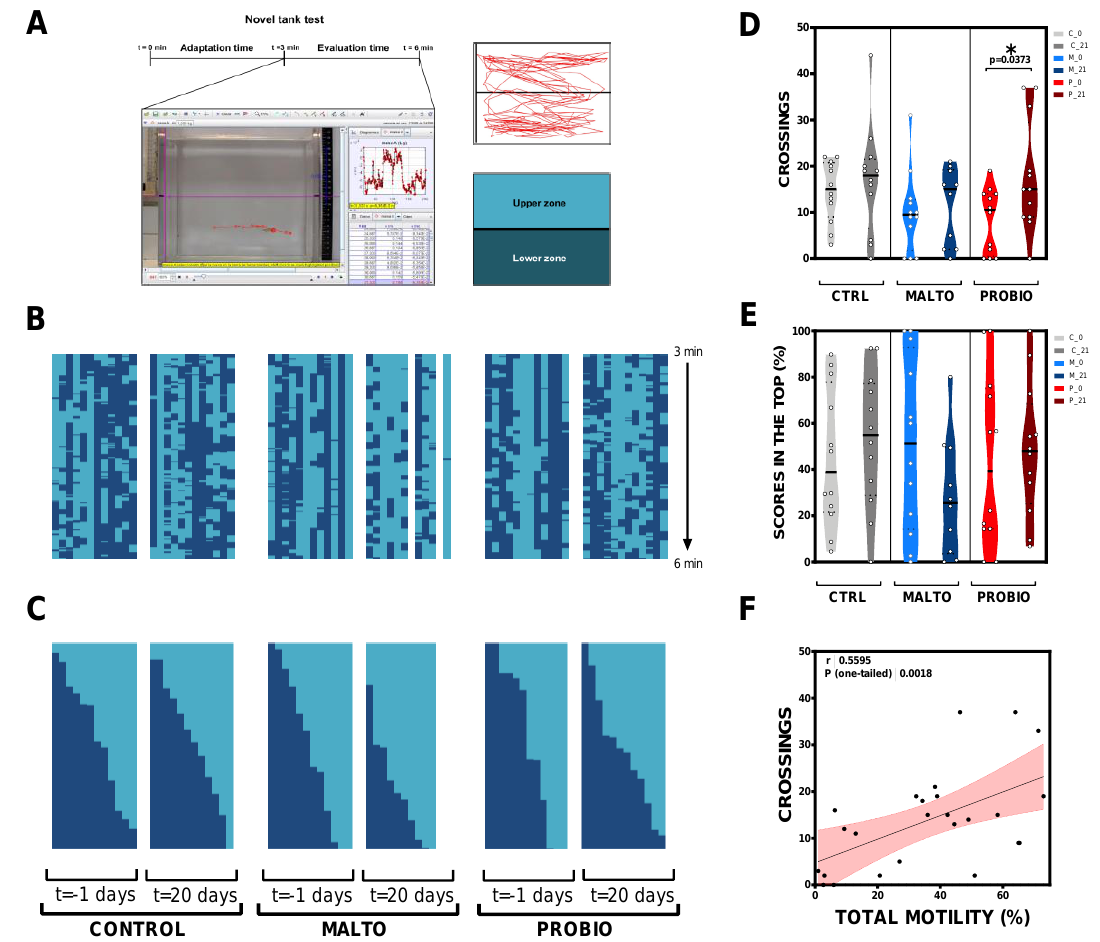
Figure 4. Probiotic bacteria ingestion modulates male behavior in zebrafish. ( A ) Schematic representation of the novel tank test (NTT). ( B ) Individual summaries of the track for each animal in the experiment at 0 and 21 days. ( C ) Organized summaries from higher to lower scores in the lower subarea. ( D ) Comparison of the scores registered in the upper zone before and after treatment. ( E ) Comparison of the number of crossings between the two subareas of the arena at 0 and 21 days. ( F ) Correlation between “number of crossings” and “total motility” variables integrating data from the three experimental groups after probiotic treatment. Asterisk shows statistically significant differences * ( p < 0.0500).